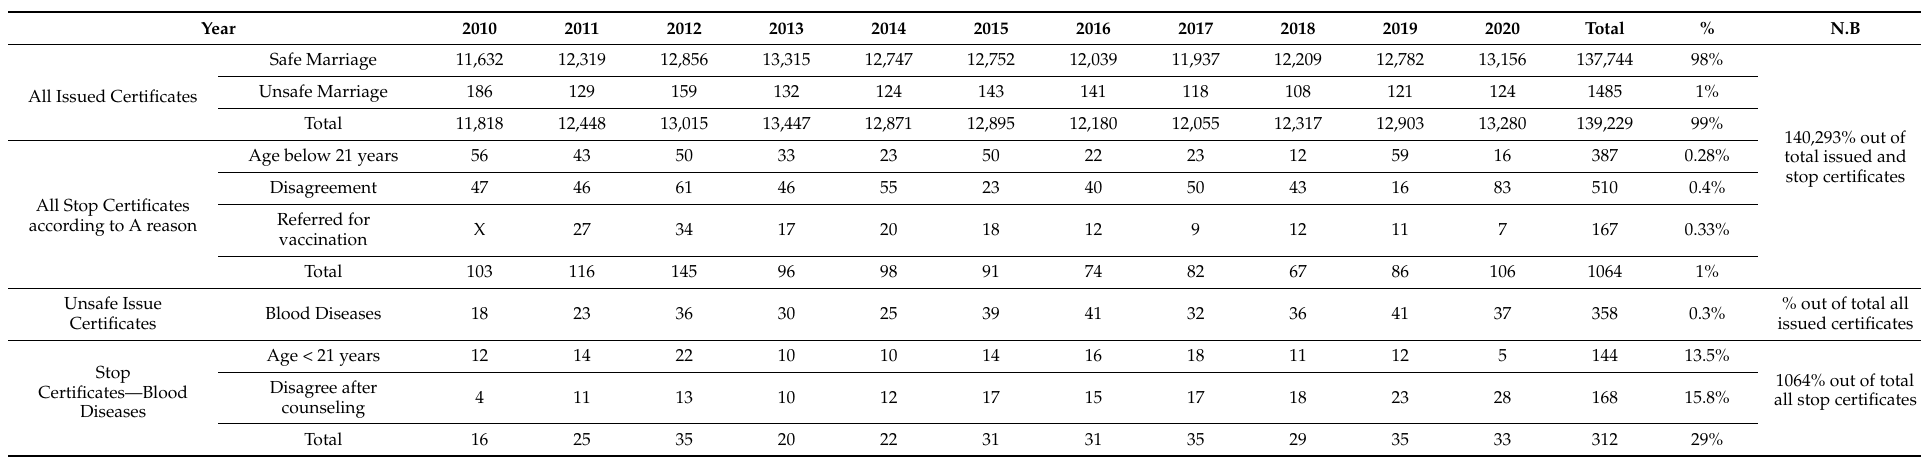
Table 4. Cumulative statistics for blood diseases for all PMC centers from